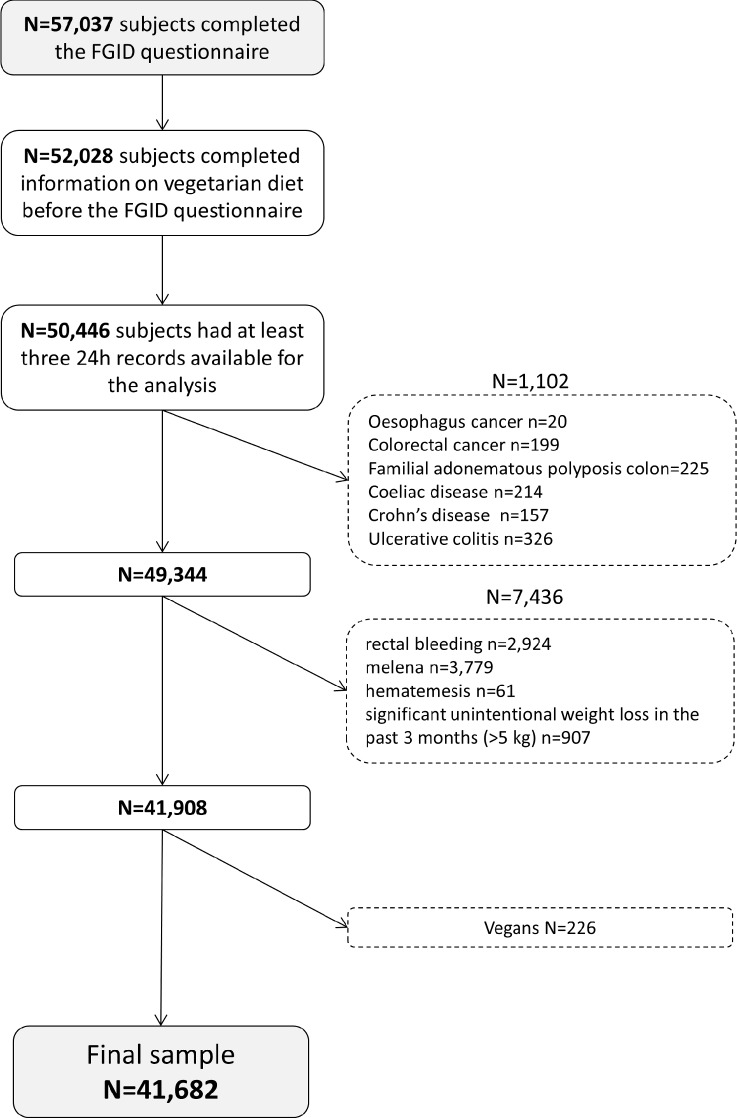
Flowchart of the study.